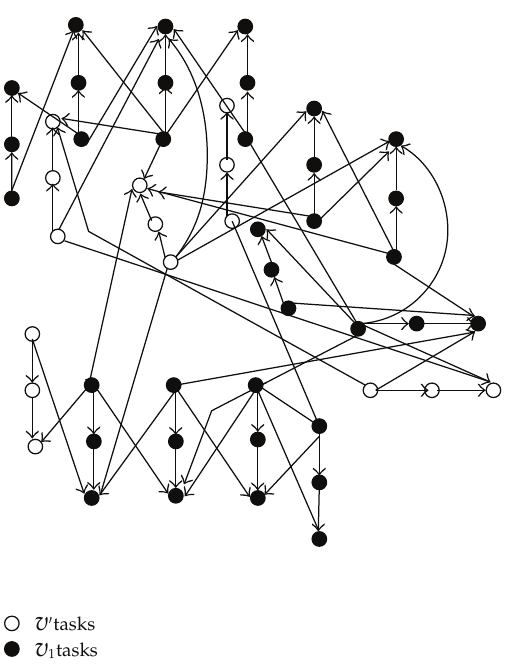
Figure 6: Next step of the construction of W graph. Path of length three is created and precedence constraints between tasks are added.